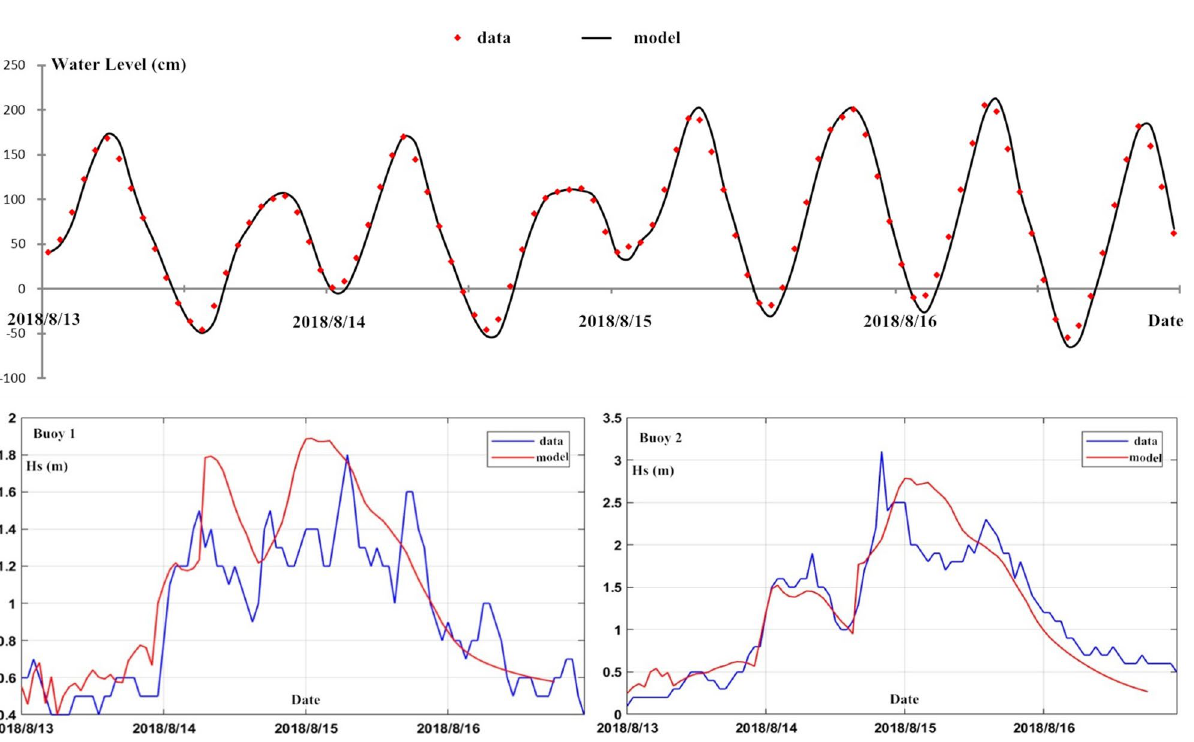
Figure 5. Time series of the computed storm tide (upper 2 panels) and waves (lower 2 panels) in comparison with observed